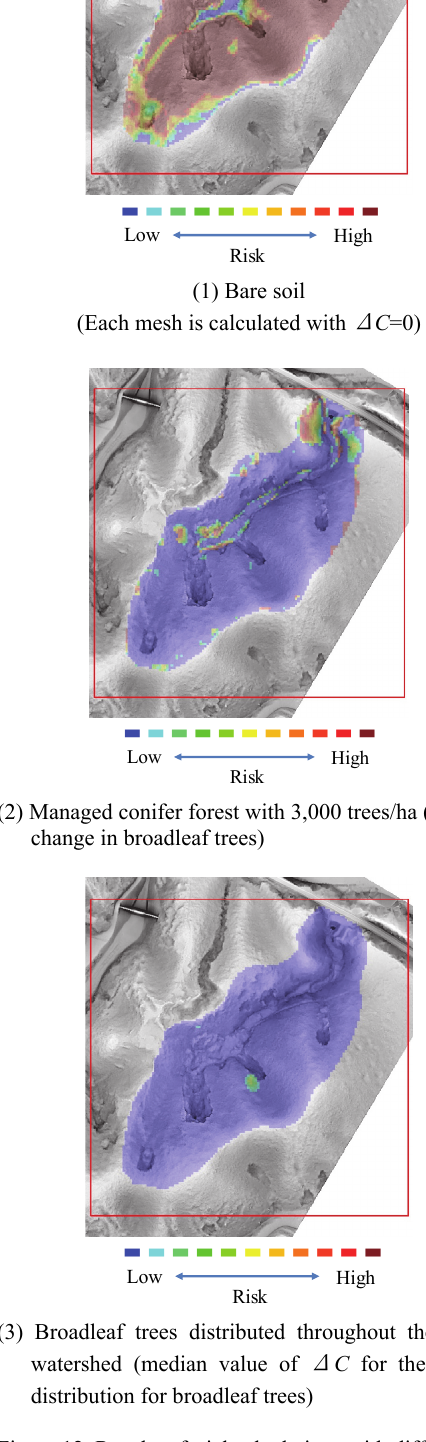
Figure 12. Results of trial calculations with differing vegetation within the watershed